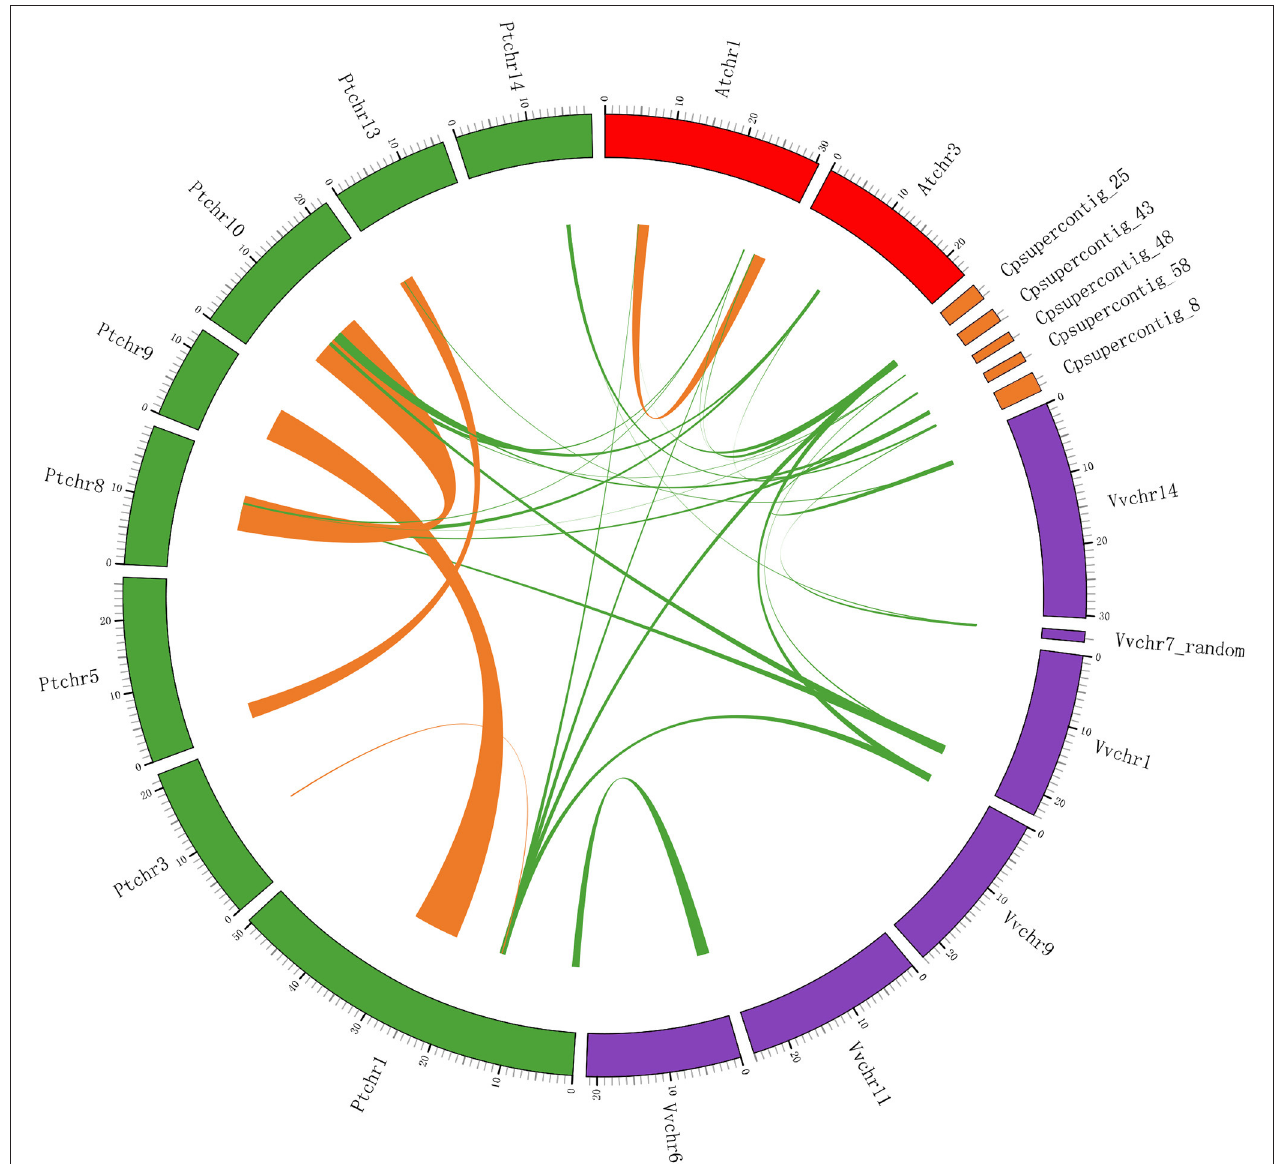
FIGURE 7 | Extensive microsynteny of LOX regions across Populus , Vitis , Arabidopsis and Carica chromosomes. The Populus , Vitis , Arabidopsis, and Carica chromosomes, shown in different colors, are labeled Pt, Vv, At, and Cp, respectively. Numbers along each chromosome box indicate sequence lengths in megabases. The whole chromosomes of these four rosid plants, harboring LOX regions, are shown in a circle. Green lines represent the syntenic relationships between LOX regions within species. Orange lines represent the syntenic relationships between LOX regions between